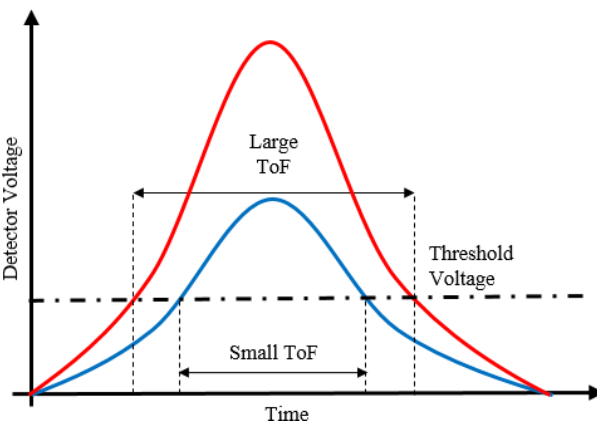
Figure 2. An illustration of the ToF dependence on particle size for UCASS measurements. The red and blue lines represent large and small particles, respectively, for the same laser beam